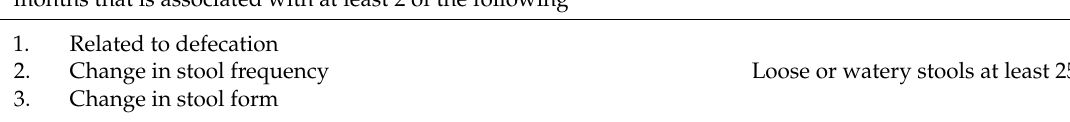
Table 1. Rome IV criteria for irritable bowel syndrome and functional diarrhoea. Rome IV Criteria for Irritable Bowel Syndrome–D, M Rome IV Criteria for Functional Diarrhoea Abdominal pain on average at least 1 day/week in the last 3 Not usually associated with months that is associated with at least 2 of the following